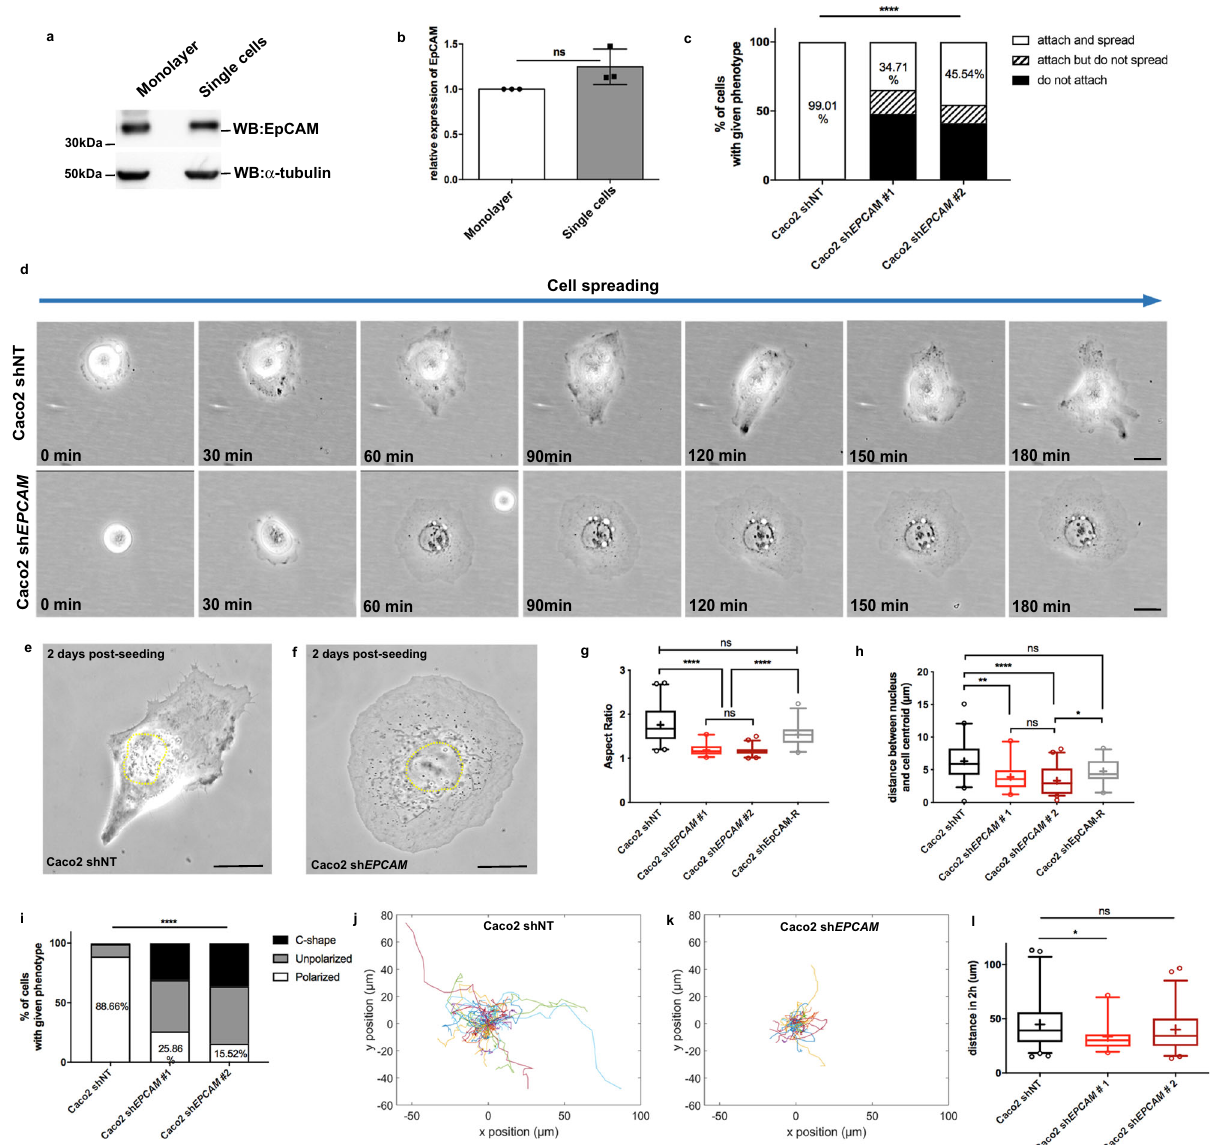
Fig. 1 EpCAM is required for single-cell front – rear polarization and migration. a , b Western blot analysis ( a ) and statistical analysis ( b ) of EpCAM expression in Caco2 21-day monolayers or single cells spread on collagen-coated petri dish and coverslips, respectively. α -Tubulin was used as a loading control. Unpaired t test with Welch ’ s correction, p = 0.1602 (non-signi fi cant). Data are mean ± SD. c Statistical analysis of cell adhesion within 3 h post- seeding for control (Caco2 shNT) or EPCAM -KD (Caco2 sh EPCAM #1 and #2) cells. The percentage of cells that attach and spread, attach but do not spread, and cells that do not attach is represented. The exact number of cells (and %) in each category is available in Supplementary Table 2. N (shNT) = 101 cells, N (sh EPCAM #1) = 121, N (sh EPCAM #2) = 112. Chi-square test computed on the number of cells with given phenotype indicates a p value < 0.0001. d Phase-contrast time lapse of control and EPCAM -KD cells during cell spreading. Imaging was performed for 3 h right after seeding. Scale bar, 5 μ m. e , f Phase-contrast representative images of control ( e ) or EPCAM -KD ( f ) 2-day post-seeding single cells. Scale bar, 5 μ m. g Statistical analysis of the aspect ratio in control or EPCAM -KD cells. Aspect ratio for shNT cells = 1.756 ± 0.42 (mean ± SD), sh EPCAM #1 = 1.188 ± 0.13, sh EPCAM #2 = 1.17 4 ± 0.11, sh EPCAM -R = 1.537 ± 0.25. The whiskers of the box plot represent the 5 – 95 percentile con fi dence intervals; the mean is displayed as a cross. N (shNT) = 41 cells, N (sh EPCAM #1) = 33, N (sh EPCAM #2) = 44, N (sh EPCAM -R) = 30. Kruskal – Wallis test and Dunn ’ s multiple comparison tests, **** p < 0.0001. h Statistical analysis of the distance between the nucleus and the centroid in control or EPCAM -KD cells. Distance between the nucleus and the centroid in shNT cells = 6.28 ± 2.96 (mean ± SD), sh EPCAM #1 = 3.911 ± 2.18, sh EPCAM #2 = 3.321 ± 2.15, sh EPCAM -R = 4.769 ± 1.88. The whiskers of the box plot represent the 5 – 95 percentile con fi dence intervals; the mean is displayed as a cross. N (shNT) = 41 cells, N (sh EPCAM #1) = 33, N (sh EPCAM #2) = 45. Kruskal – Wallis test with Dunn ’ s multiple comparison test, *adjusted p = 0.0212, **adjusted p = 0.0014, ****adjusted p < 0.0001. i Statistical analysis of polarity phenotypes in control or EPCAM -KD cells. The percentage of cells polarized, unpolarized, and C-shaped is represented. The exact number of cells (and %) in each category is available in Supplementary Table 3. N (shNT) = 97 cells, N (sh EPCAM #1) = 58, N (sh EPCAM #2) = 58. Chi-square test computed on the number of cells with given phenotype indicates a p value < 0.0001. j , k Color map of cell tracks in control ( j ) and EPCAM -KD ( k ) cells. l Statistical analysis of the distance traveled by control and EPCAM -KD cells within 2 h. The whiskers of the box plot represent the 5 – 95 percentile con fi dence intervals; the mean is displayed as a cross. N (shNT) = 67 cells, N (sh EPCAM #1) = 37, N (sh EPCAM #2) = 52. Kruskal – Wallis test and Dunn ’ s multiple comparison test, * p = 0.0481. Each experiment was replicated independently three times. ns non-signi fi cant. NATURE COMMUNICATIONS| (2021) 12:2226